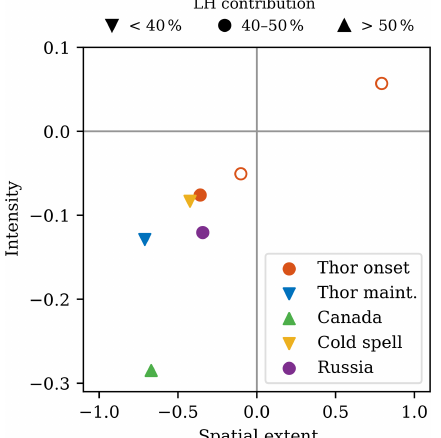
Figure 11. Normalized difference in peak spatial extent and peak intensity of the NOLH blocks compared to the CNTRL blocks. Val- ues close to zero indicate weak sensitivity. Markers indicate the LH contribution in the CNTRL simulations (see Table 1). Red open cir- cles show Thor onset simulations with reduced LH ( α = 0 . 5) and enhanced LH ( α = 1 .